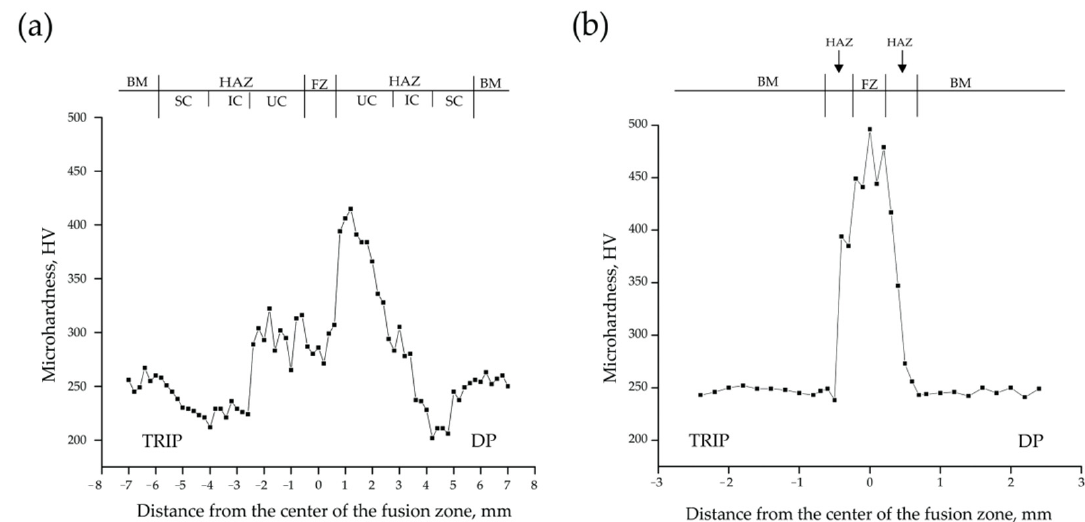
Figure 9. Microhardness Vickers profile along the weldment for ( a ) GMAW and ( b ) LBW.